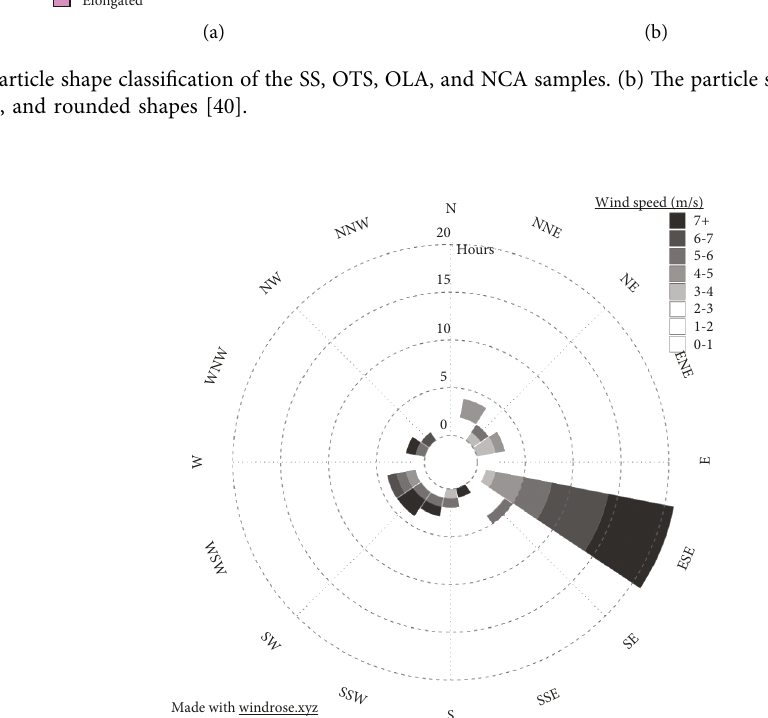
Figure 9: The wind rose presentation of the wind speed data in SS near the Oldupai Gorge area. The data were taken by using the Youshiko digital weather station from October 2020 to September 2021.